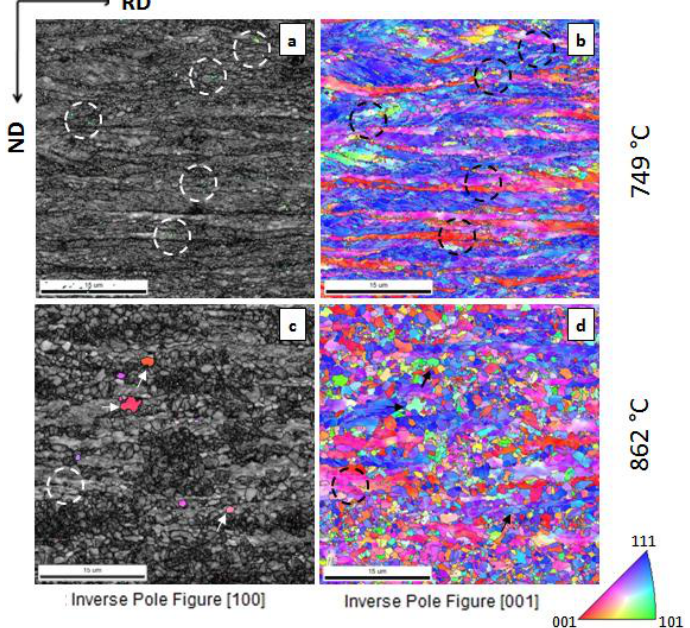
Figure 10. Microstructure of samples heated at 1500 ◦ C/s to 749 ◦ C ( a , b ), and to 862 ◦ C ( c , d ). The microstructure consists of a mixture of ferrite and martensite. Arrows indicate grains oriented close to the Goss {110}<001> ( c , d ), and circles the rotated Goss {110}<011> ( a , b ) components. ( a , c ) correspond to IQ maps in which the recrystallized grains of ferrite are highlighted by a [100] RD Inverse Pole Figure (IPF) map. ( b , d ) are [001] ND IPF